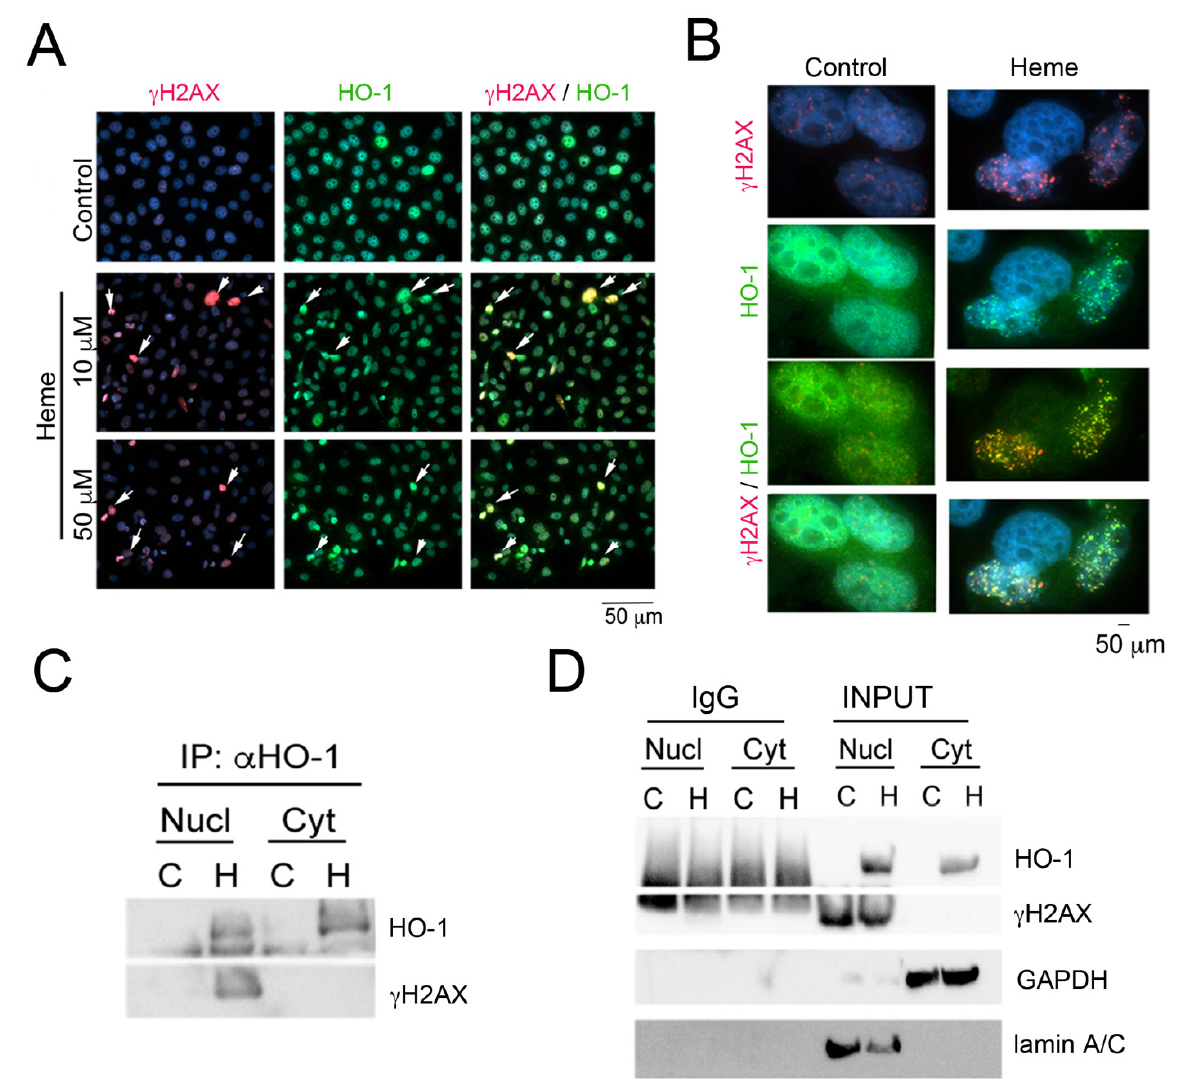
Figure 4. Heme induces DNA damage and accumulation of cells in the G2/M phases. ( A , B ) Immunofluorescent staining for HO-1 and γ H2AX in PC3 cells treated with 50 µ M heme for 24 h. n = 3 experiments ( A —200 × , B —630 × magnifications). ( C , D ) Immunoprecipitation (IP) with antibody against HO-1 ( α -HO-1) in the nuclear and cytoplasmic fractions of PC3 cells treated with heme (H) or control cells ( C ). Input proteins and IgG pull-downs are shown in ( D ). Results are representative of 3 independent experiments.